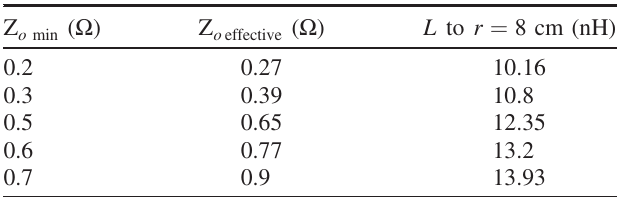
TABLE I. Effective impedance and inductance of the CSMITL reference